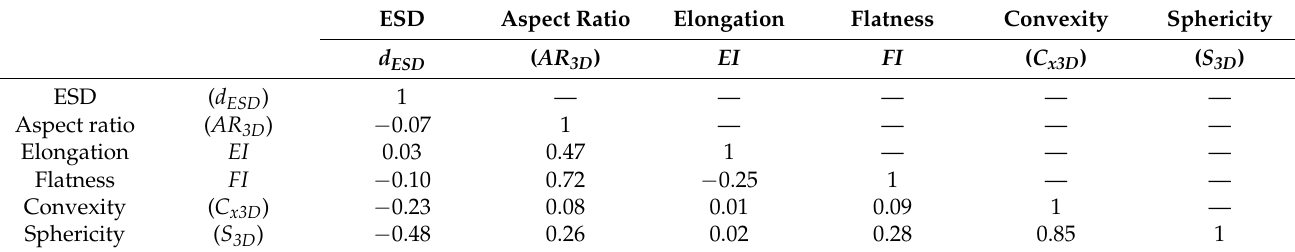
Table 6. Three-dimensional shape parameter correlation